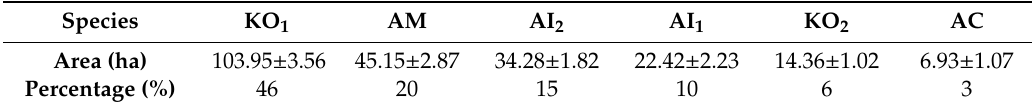
Table 7. The areas of six mangrove species in the Mai Po estimated using Random Forests with SH-GF5VN.